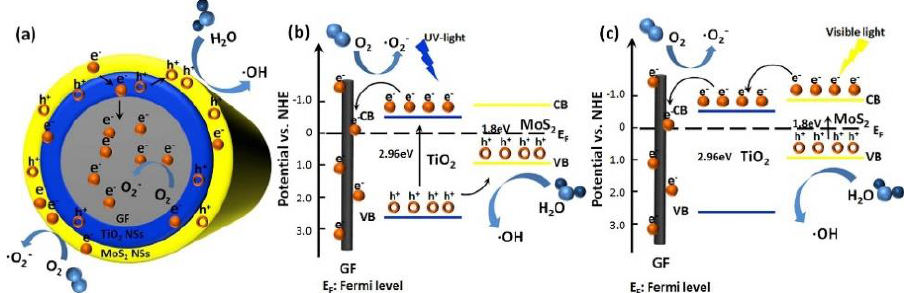
Figure 21. Structure ( a ) and schematic diagram of electron-hole separation mechanism upon UV ( b ) and visible light ( c ) excitation for 3D graphene@MoS 2 -TiO 2 composites. Reprinted with permission from [136]. Copyright 2017, Elsevier.